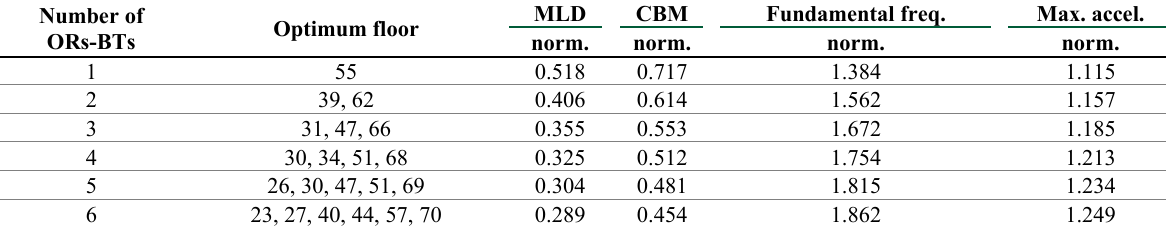
Table 2. Results of single-objective optimizations for MLD (OR-BT) MLD CBM Fundamental freq. Number of Optimum floor ORs-BTs